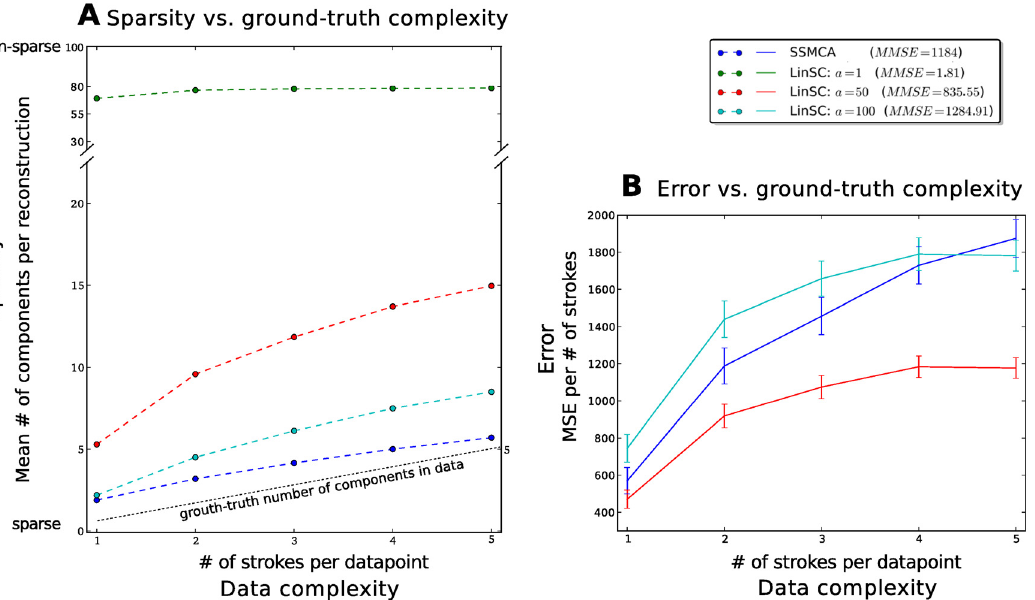
Fig 6. Comparative experiments of linear and nonlinear sparse coding on dictionary learning and image reconstruction. With H = 100 learned dictionary components we evaluate the number learned and used for reconstruction. A shows the relationship between sparsity (number of components used for reconstruction) and data complexity (number of strokes in the data). Interestingly, the SSMCA plot (blue curves) shows a nearly linear relationship of the number of components used for reconstruction versus the number of components (strokes) actually in the data, suggesting that reconstruction- complexity of the data by nonlinear model more closely follows the actual complexity in the data. On the contrary, the linear parameterization that yields good reconstruction results a = 1 shown in green, does not adapt to the data complexity at all: it consistently uses nearly 80 of the learned 100 components per reconstruction, regardless of the data point ’ s actual complexity (note the change in scale of the y -axis around 30 components in order to fit the green curve on the plot). B shows the relationship of the mean squared error (MSE) of the reconstructions of all versus the corresponding data complexity (number of strokes in the data). When the reconstruction-complexity (sparsity) is far from the actual complexity of the data (linear methods: red, a = 50 and green a = 1 cases) the MSE improves. However, when the sparsity is more closely matched to the data, SSMCA and the weakly regularized linear methods result in a poorer MSE. SSMCA nevertheless yields a better MSE in this case, even when it and linSC a = 100 have a very similarly sparse solutions/use the same number of components. Note that the error of the least sparse LinSC approach ( a = 1) is so low (mean MSE = 1.81), it does not even appear on this graph. Error bars shown are scaled to be 10% of the standard deviation for all methods in all stroke-complexity cases. The mean MSE (averaged over the entire dataset) is shown in the legend next to the respective